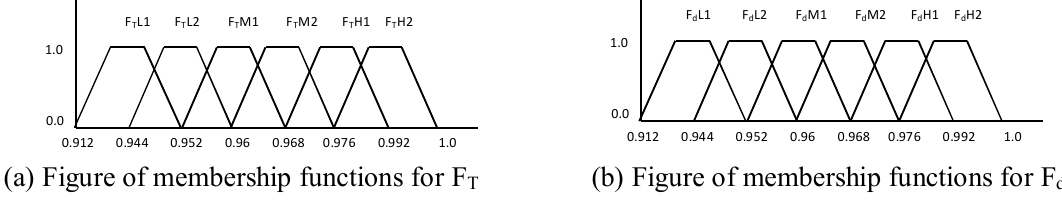
(a) Figure of membership functions for F (b) Figure of membership functions for F T Fig. 6 . Membership functions for responses